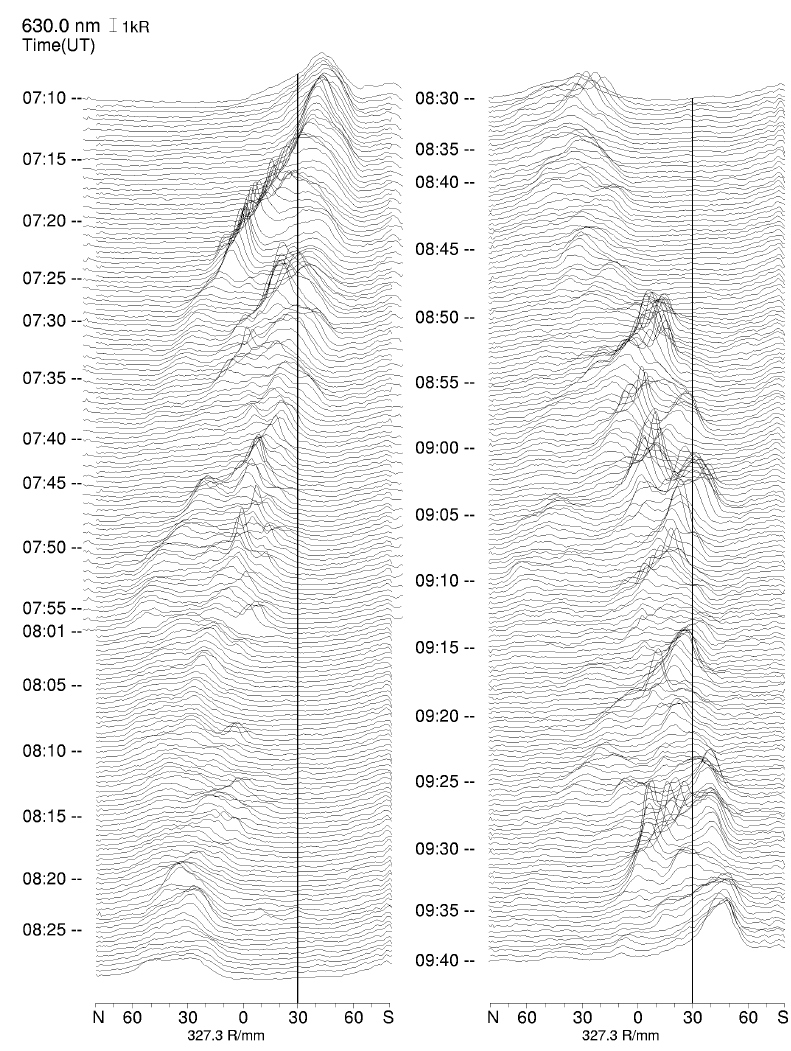
Fig. 2. Intensity of the 630.0nm (red-line) auroral emission measured by the MSP at Ny ˚Alesund from 07:10 UT to 09:40 UT, on 20 December 1998, as a function of zenith angle. The dark line near 30 ◦ S of zenith shows the latitudinal location of the ESR radar mapped into the zenith angle